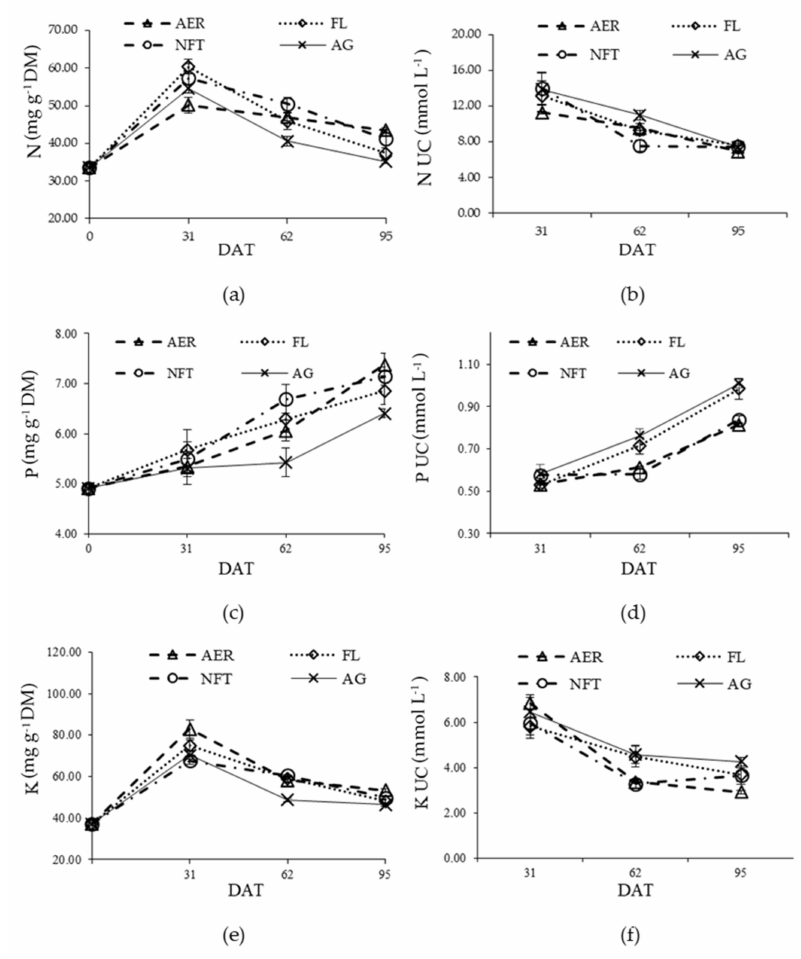
Figure 7. Impact of the different CSCS on the concentrations in the plant dry mass (DM) and on the corresponding apparent uptake concentrations (UC), i.e., mmol of the element uptake per L of water uptake of N, P, and K. Vertical bars indicate ± standard errors of means of twelve (12) samples per